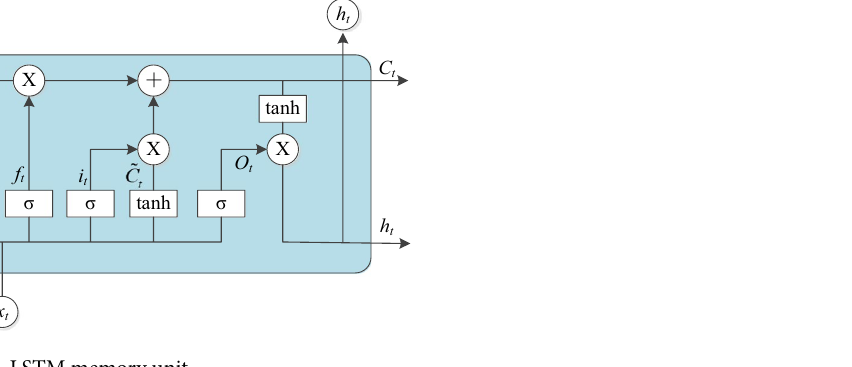
Figure 1. LSTM memory